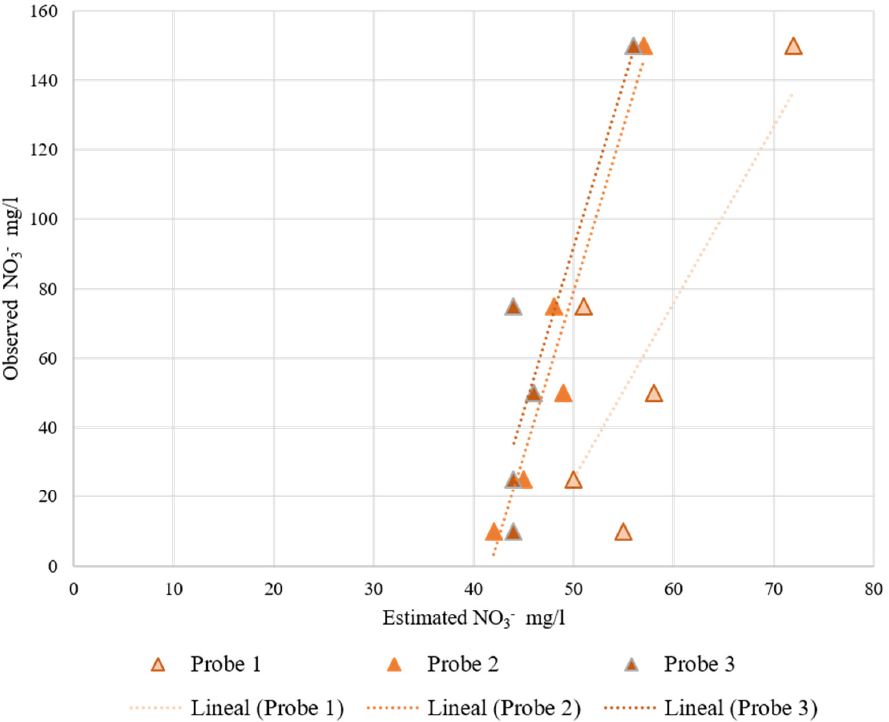
Figure 11. RIKA probes’ behavior at increasing nitrate concentration at a 35% volumetric soil moisture. On the x -axis is the estimated nitrate concentration measured by the probes and on the y -axis is the observed nitrate concentration. Table 6. Fitting and determination coefficient for the RIKA probes when increasing the nitrate con- centration in sand at 35% volumetric soil moisture.